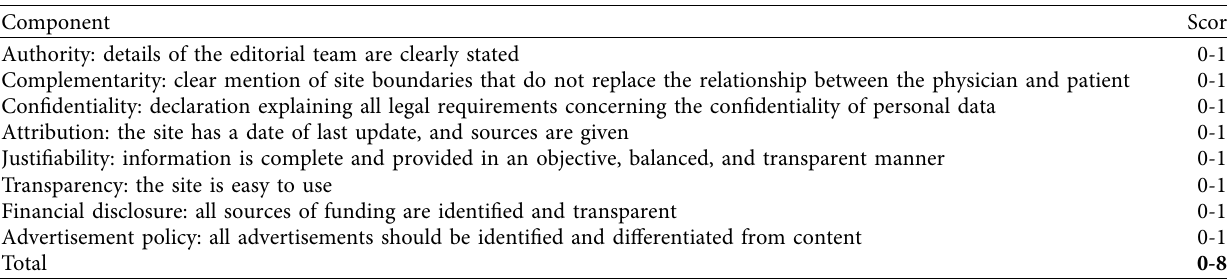
Table 4: Health on the Net (HON).